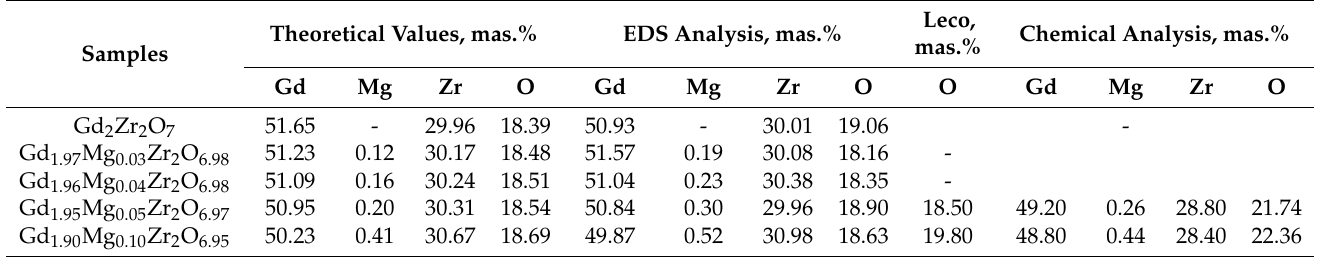
Table 1. Elemental composition, determined by the EDS and chemical analyzes, and oxygen content determined by the LECO analysis, for the investigated